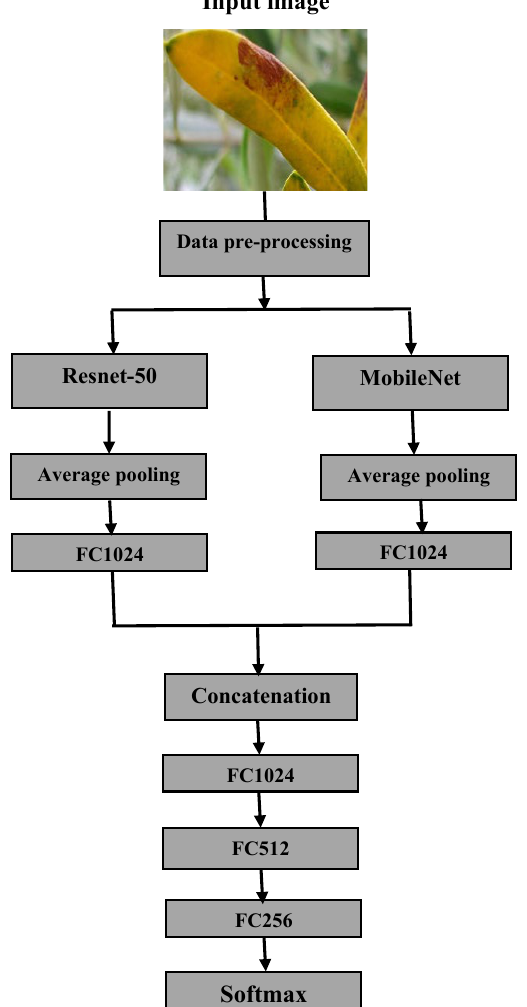
Figure 7. Architecture of the proposed hybrid MobiRes-Net model.